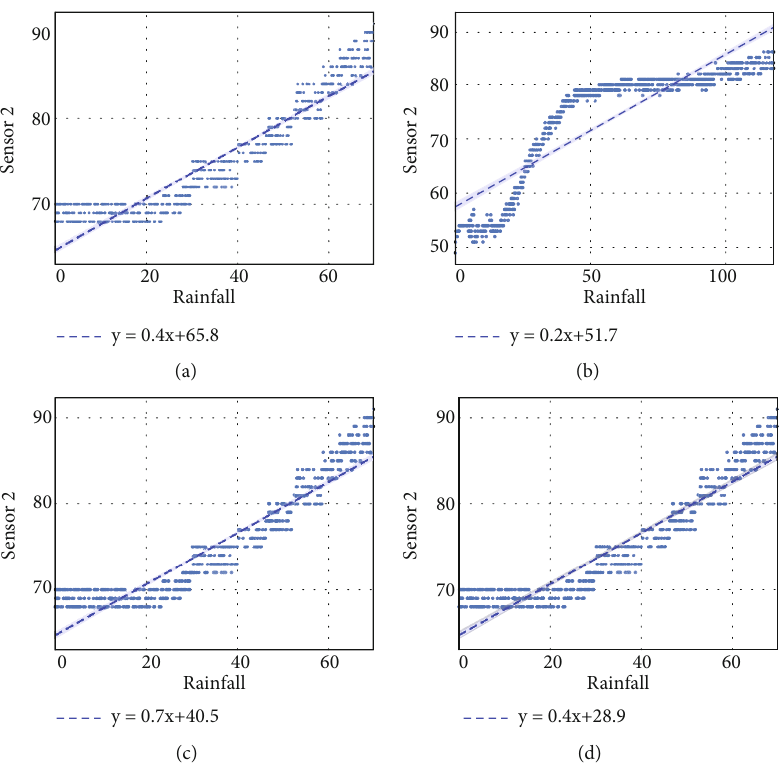
Figure 11: Rainfall vs. soil moisture: (a) SD2, (b) SD1, (c) SE2, and (d) SE1.